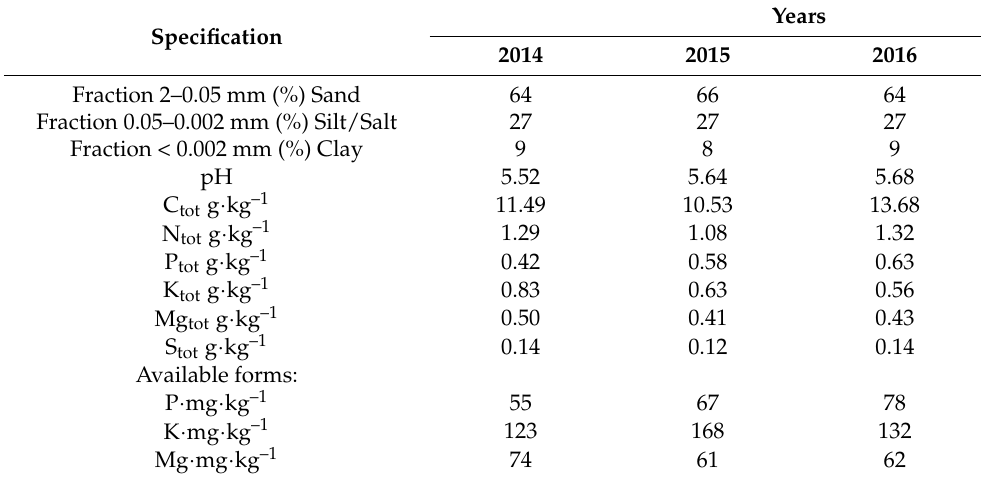
Table 3. Basic soil characteristics.